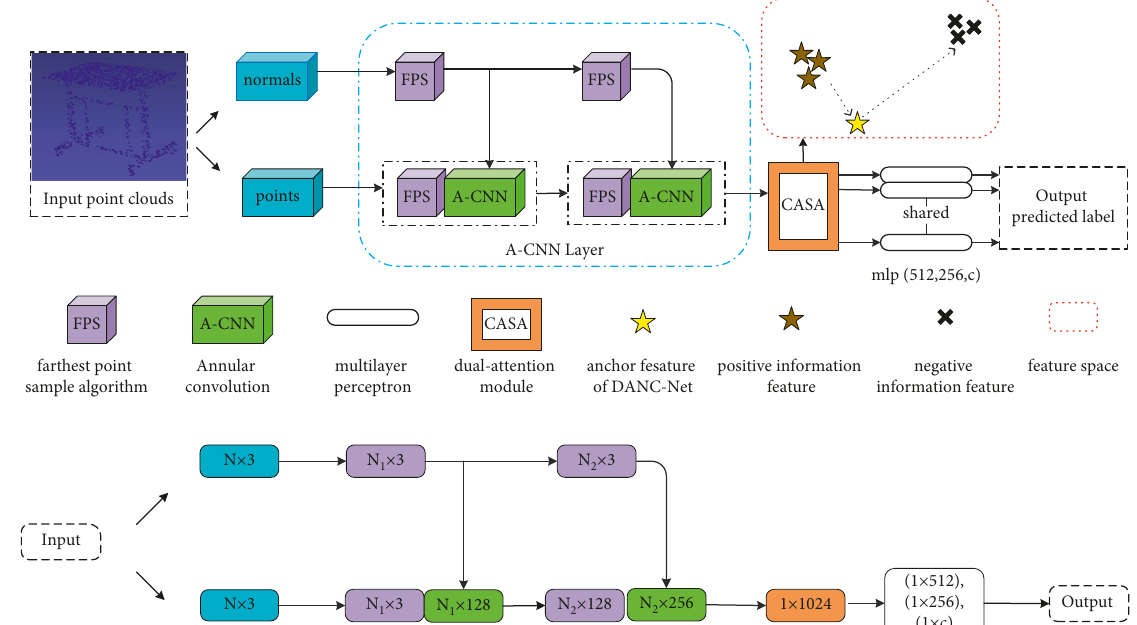
Figure 2: The architecture of DANC-Net (top) and the feature map size of each node of the model (bottom). The blue dashed box on the left of the network structure is the local feature extraction layer (A-CNN layer).